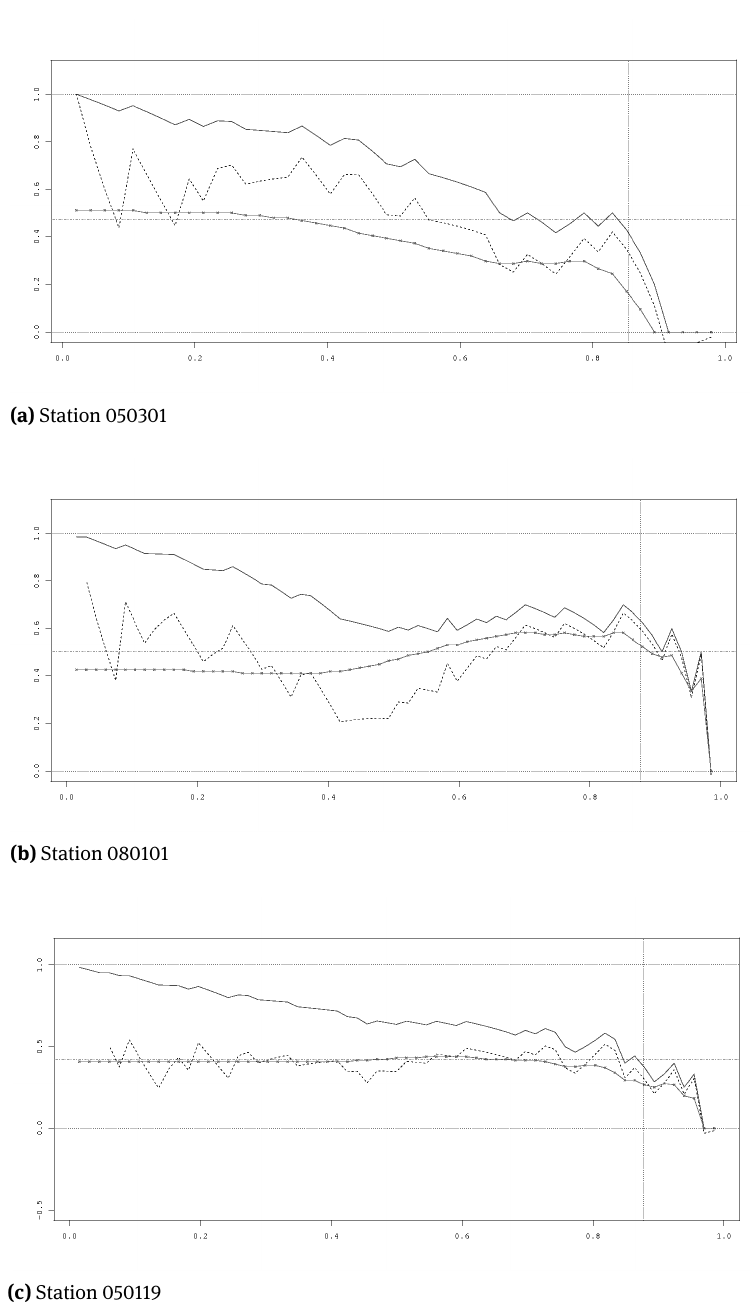
Figure 4: Estimators of the tail dependence function χ (.) of the pair ( Q , V ) . The vertical axis corresponds to ˆ χ ( u ) with ˆ χ LOG (- - - -) and ˆ χ SEC (—), ˆ χ DF (- × - × -) and ˆ χ F ( - · - · -), while the horizontal axis corresponds to thresholds u = 1/ n , 2/ n , 3/ n , . . . , 1 − 1/ n U U , k and k = n − 1, n − 2, . . . , 1 . In horizontal dotted line, the upper and lower bounds on χ (.) . In vertical dotted line, the chosen